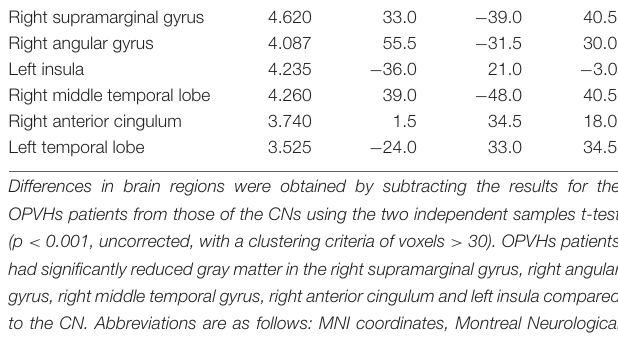
gyrus, right middle temporal gyrus, right anterior cingulum and left insula compared